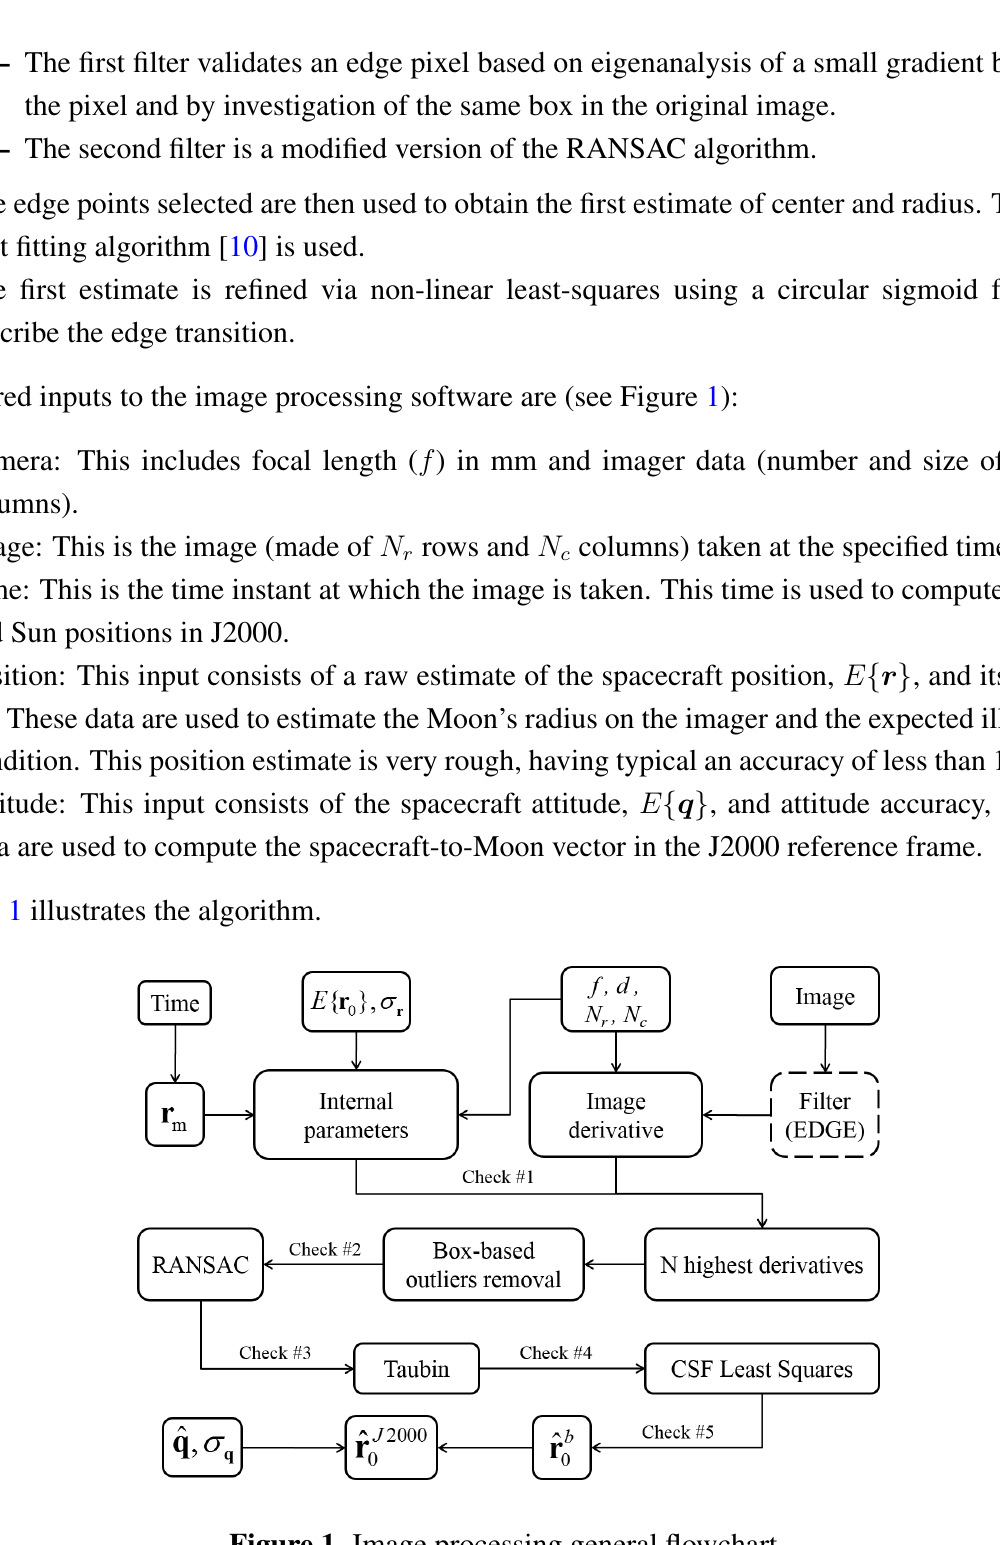
Figure 1. Image processing general